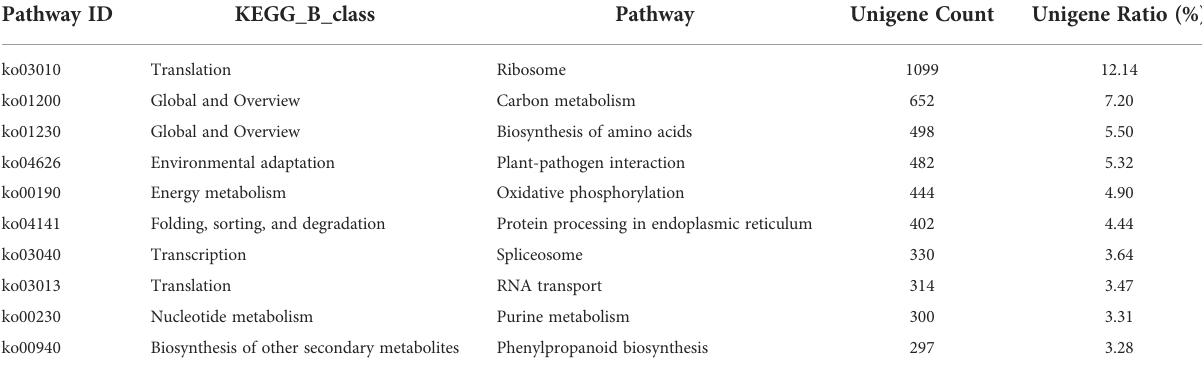
TABLE 2 Pathway list of unigenes (only the fi rst 10 rows).